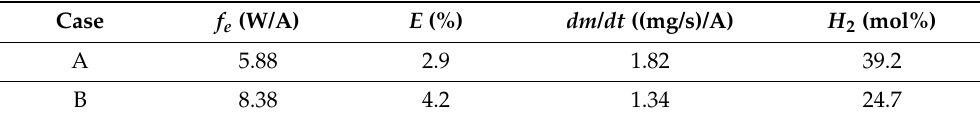
Table 3. Electrical conversion factor, f e ; overall energy efficiency, E; and specific mass flow rate, dm/dt. Last column gives the mole percent hydrogen for the corresponding